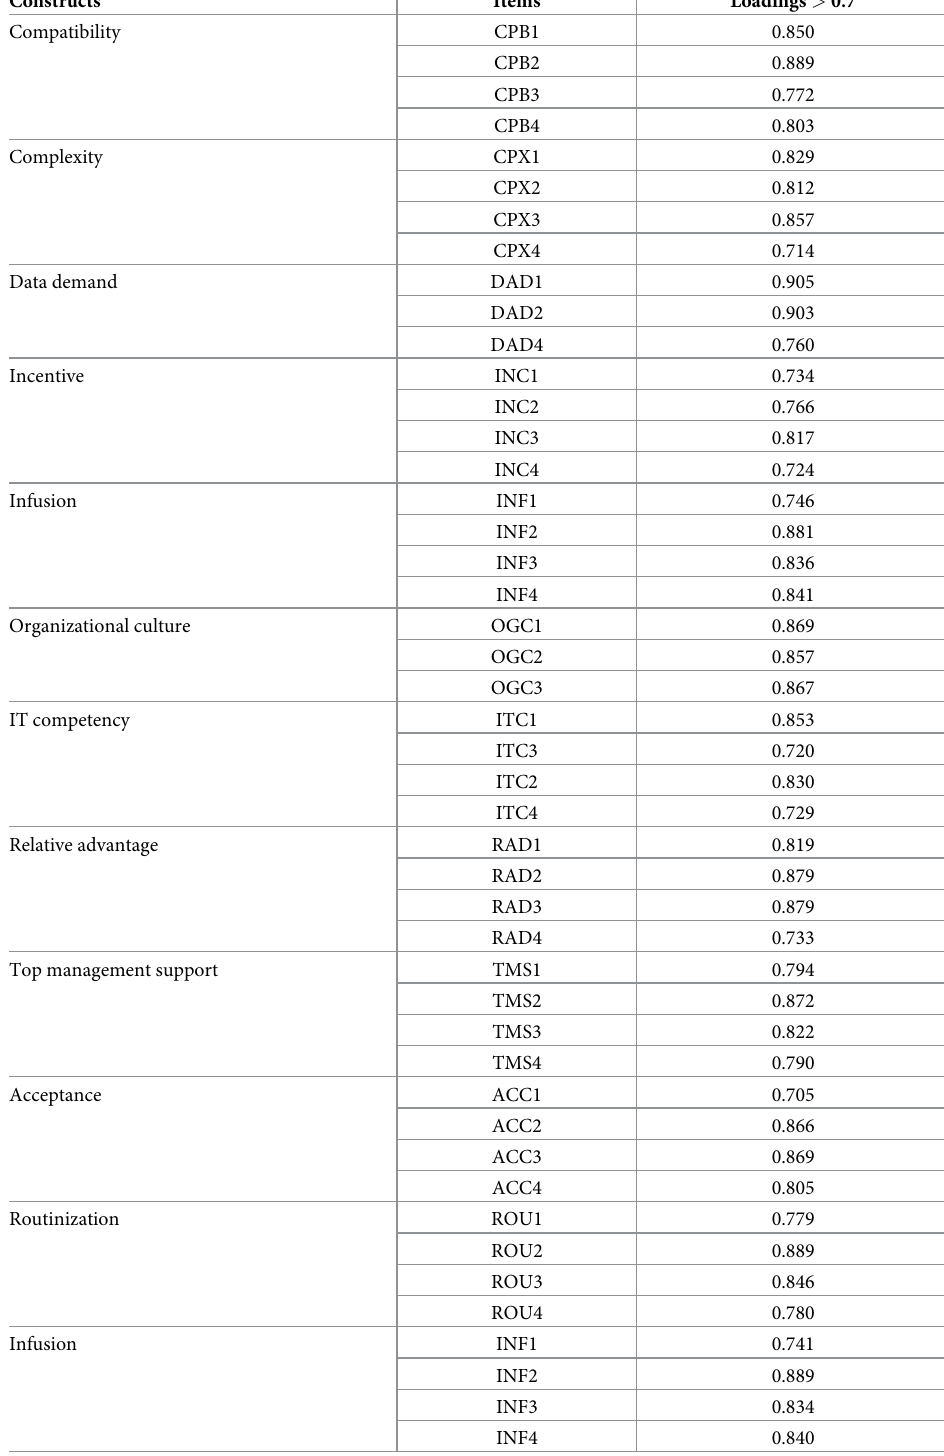
Table 6. Indicator loading index in indicator reliability